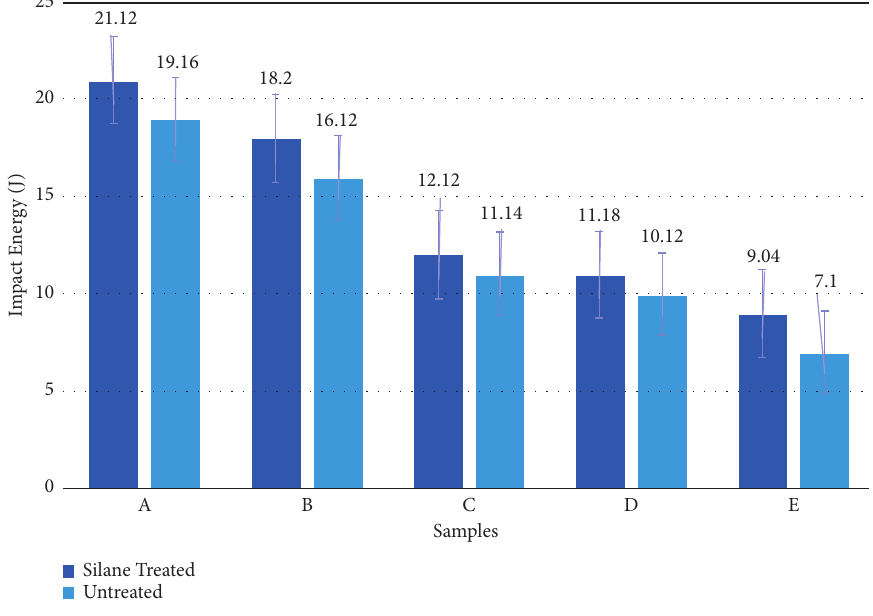
Figure 6: Impact strength of the hybrid epoxy composite. Table 5: Impact test results of epoxy